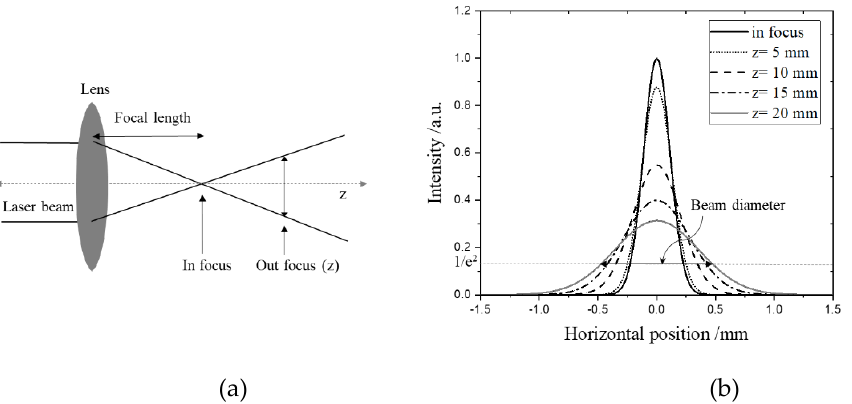
Figure 3. Laser beam profiles according to the Z positions. ( a ) Schematic drawing for the laser beam divergence; ( b ) simulated Gaussian intensity distributions according to the Z position.